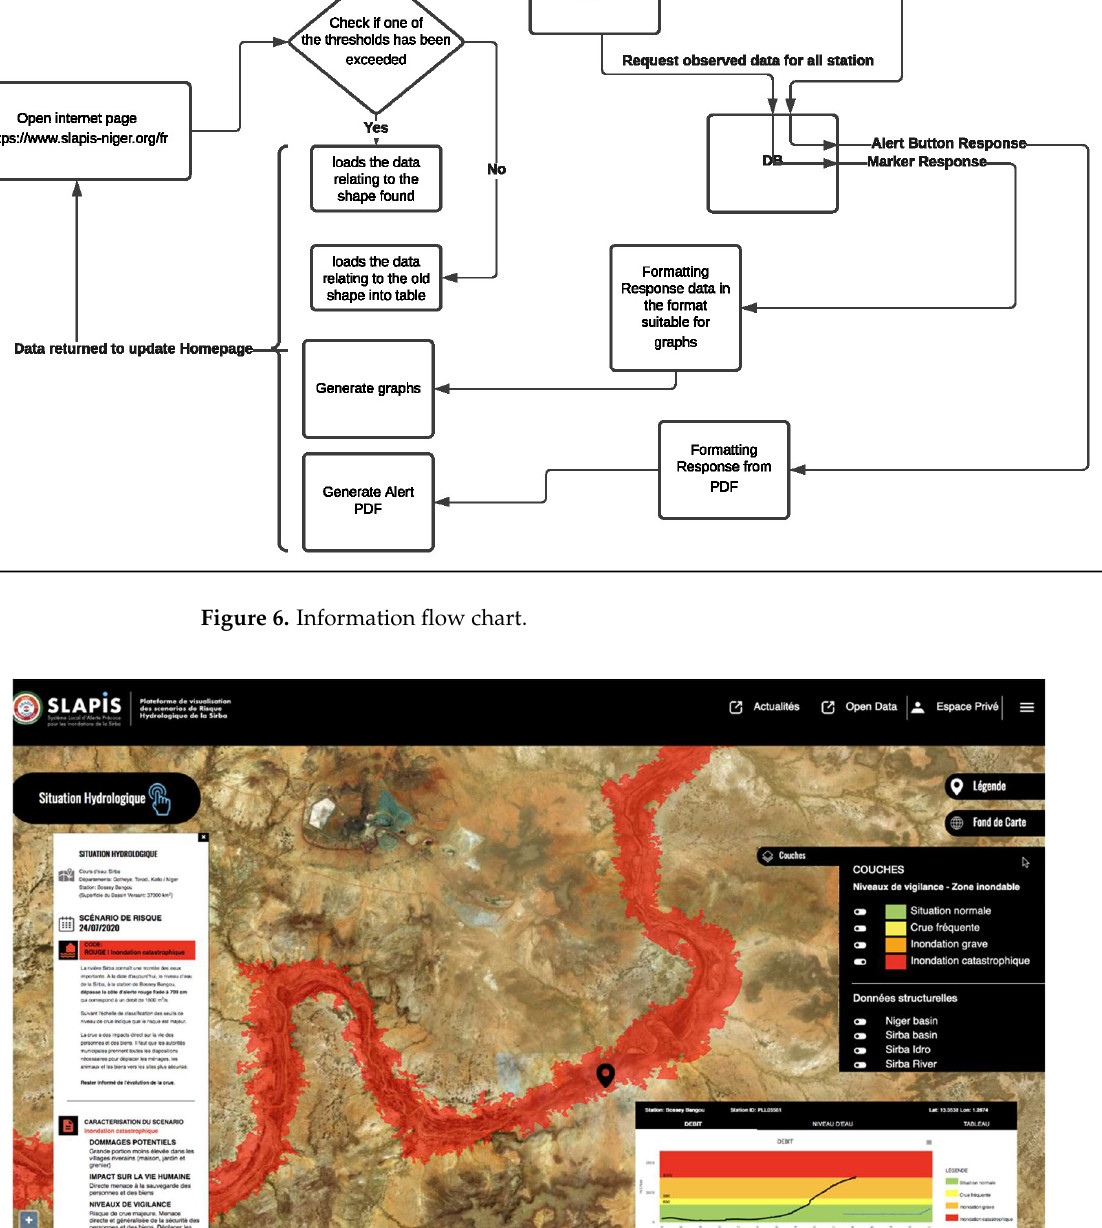
Figure 7. Web application interface: risk scenario and hydrological threshold reached in July 2020.